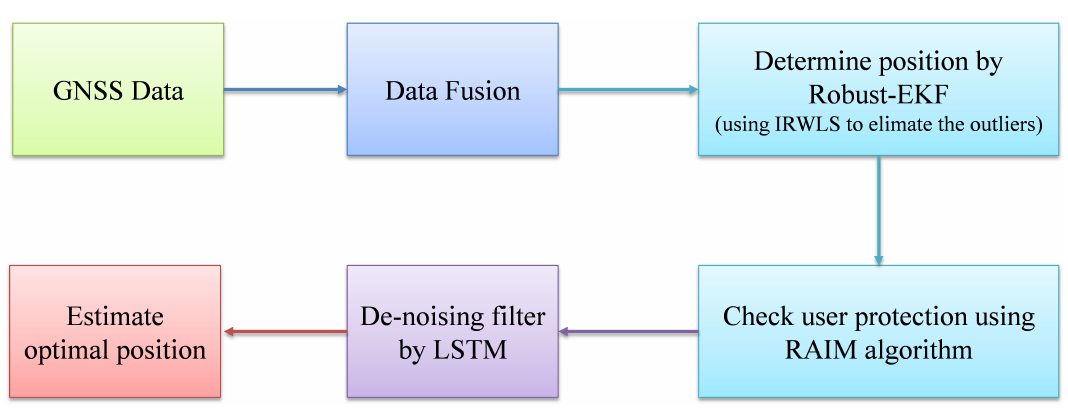
Figure 1. Global flowchart for the position